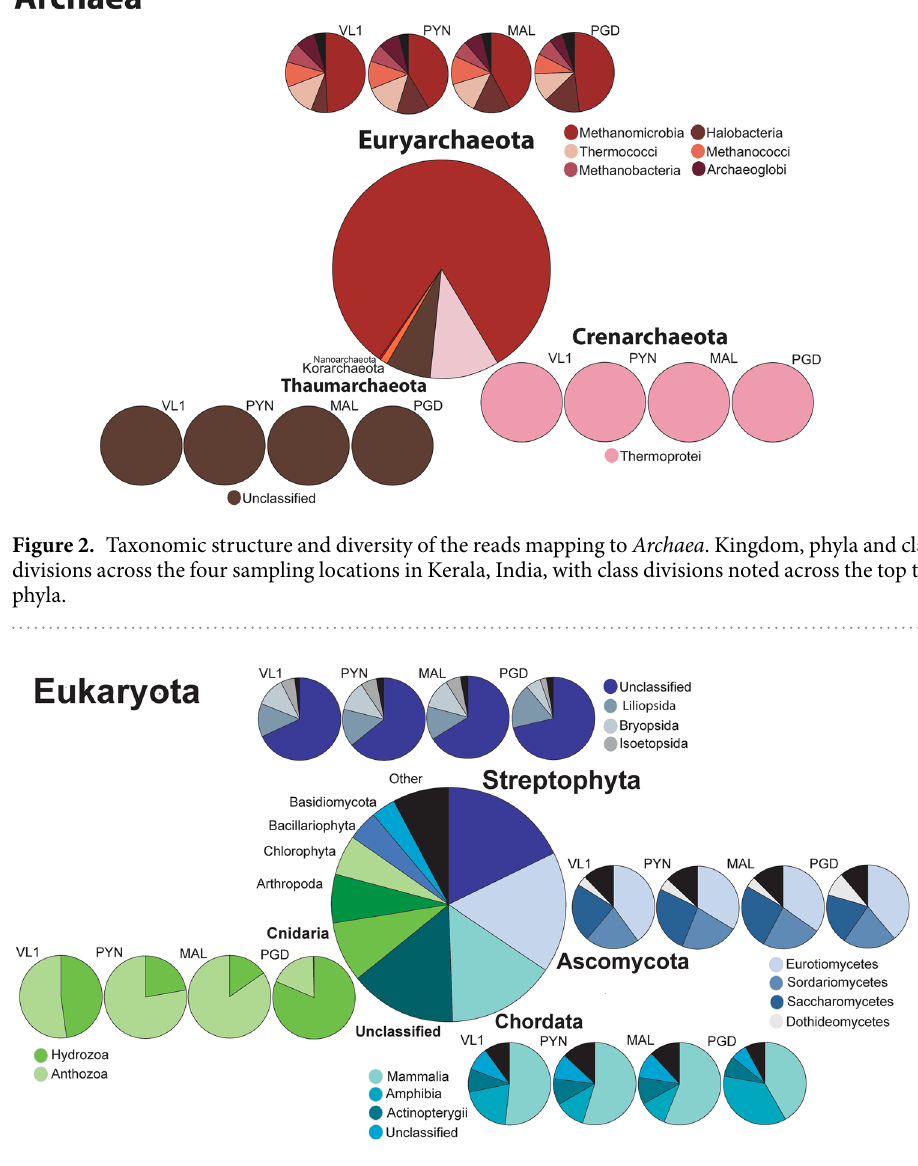
Figure 3. Taxonomic structure and diversity of the reads mapping to Eukaryota . Kingdom, phyla and class divisions across the four sampling locations in Kerala, India, with class divisions noted across the top four